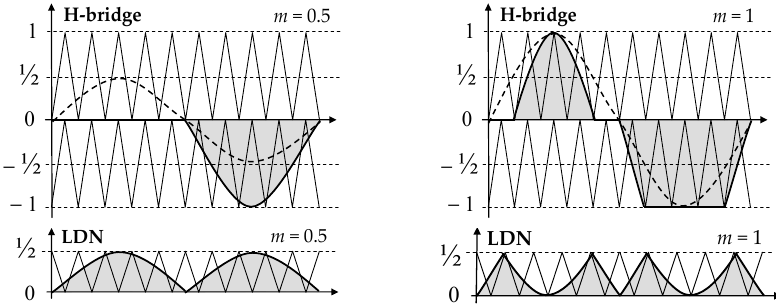
Figure 2. Modulation principle for multilevel pulse-width modulation: carriers and modulating signals for H-bridge ( top ) and LDN ( bottom ) in the case of m = 0.5 ( left ) and m = 1 ( right ).